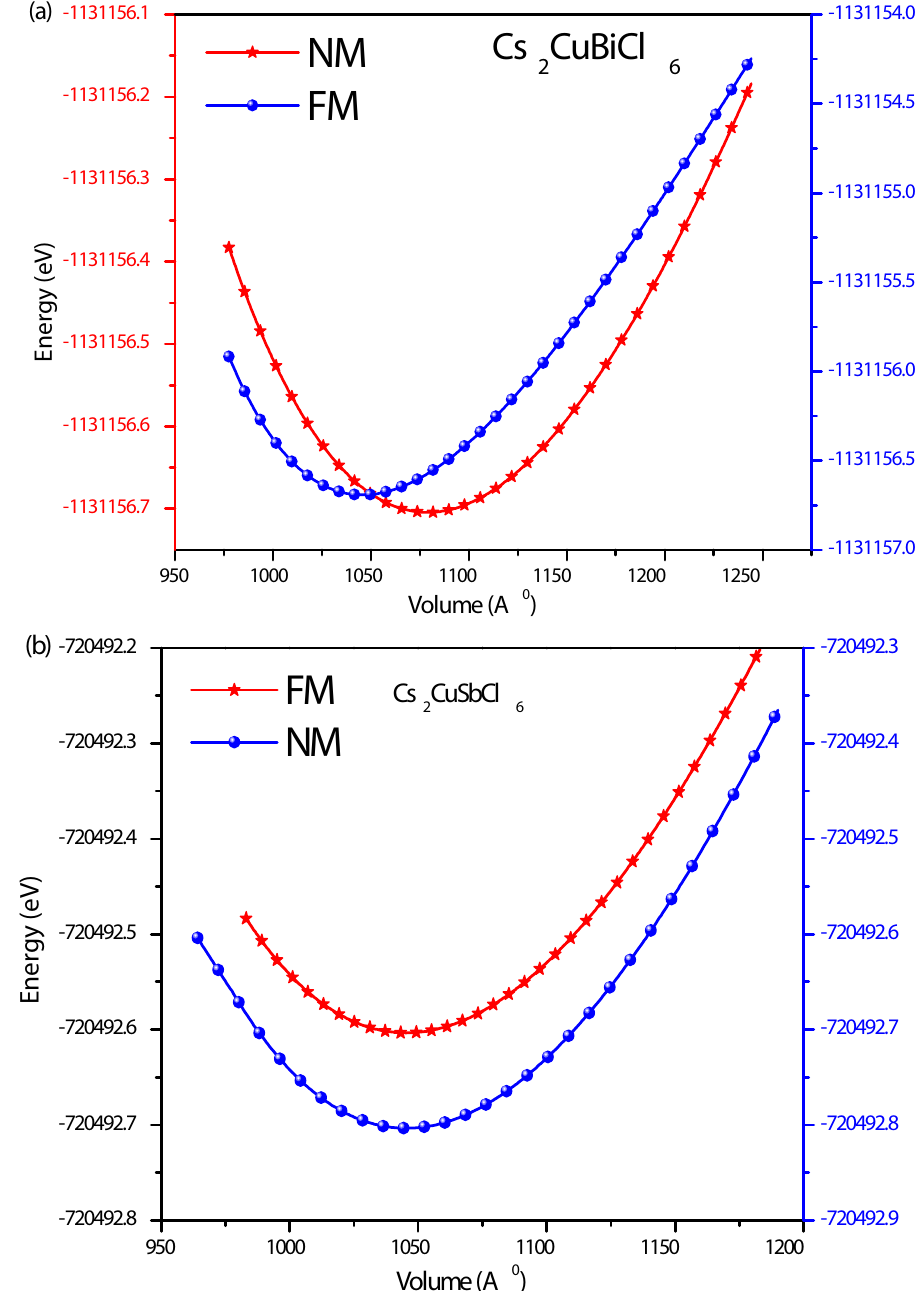
Figure 1. ( a , b ) Energy versus volume optimization curve of Cs 2 CuMCl 6 (M = Sb, Bi) in both spin-polarized and non-polarized